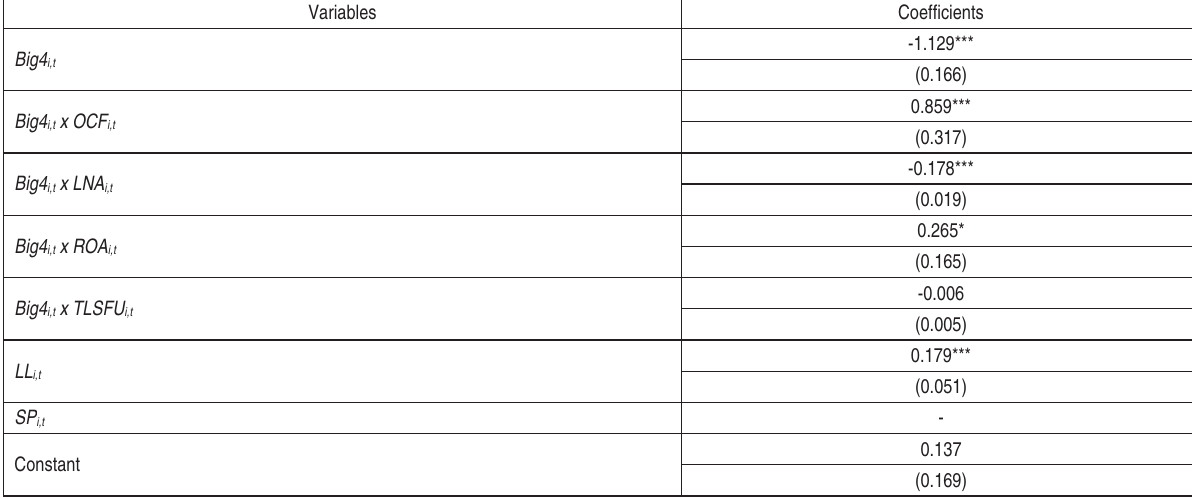
Table 2. Discretionary accruals and Big 4 auditing (equation 1) (cid:3)